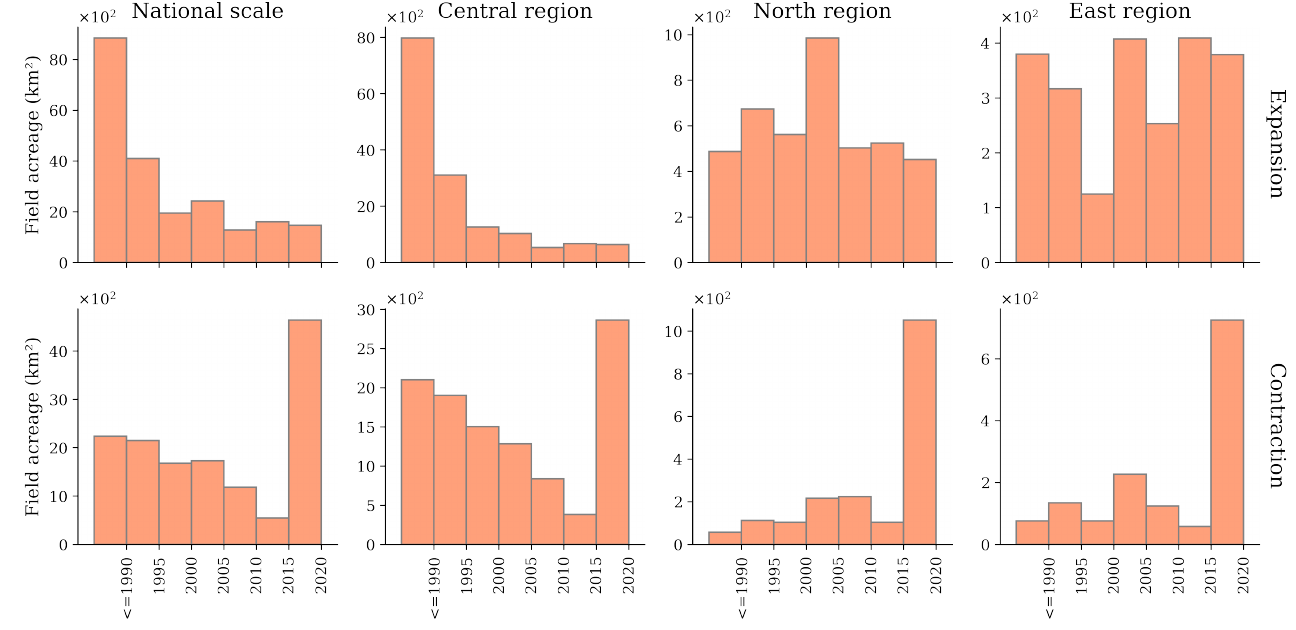
Figure 13. The histogram of field acreage calculated from the year of the first detection ( upper row) and the last detection before 2021 ( lower row) of each pixel identified as a center-pivot field (CPF) pixel in successive 5-year periods. The pixels detected as CPFs in 2021 were not shown in the contraction map because they were still in use. The upper and lower rows correspond to Figures 11 and 12,